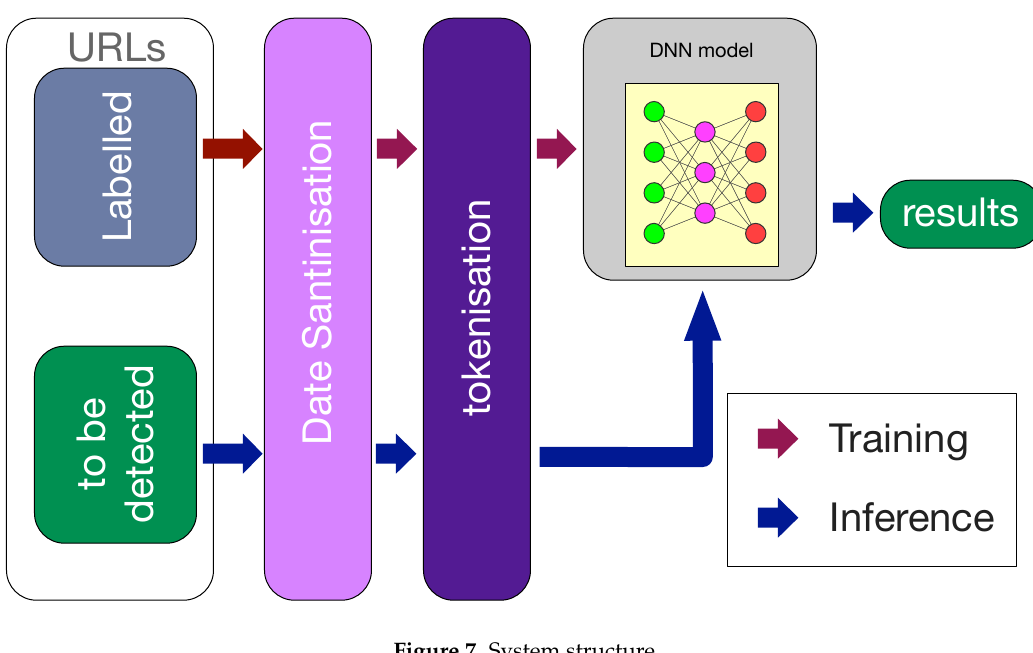
Figure 7. System